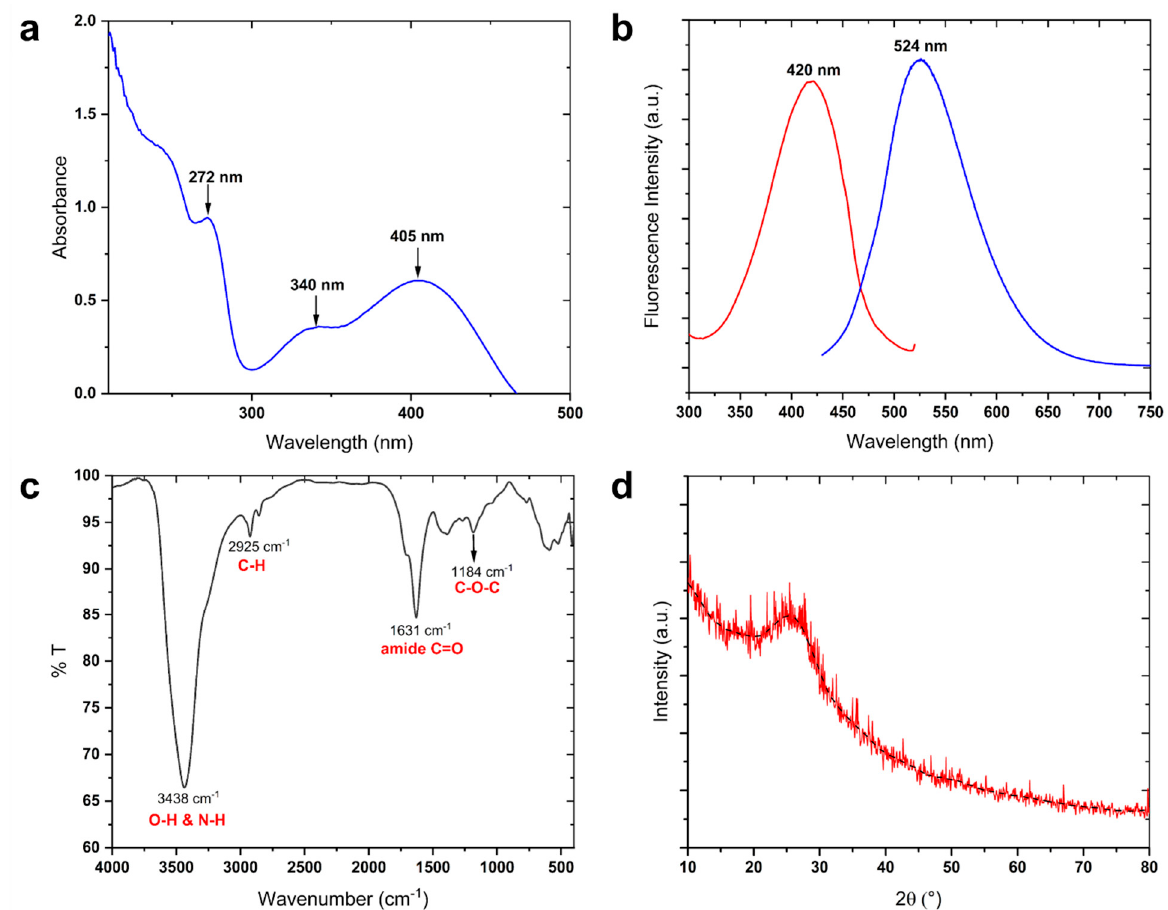
Figure 2. ( a ) UV-Vis spectrum of the microwave-synthesized C-dots showing three peaks at 405, 340, and 272 nm, ( b ) fluorescence spectrum of the microwave-synthesized C-dots showing excitation and emission peaks at 420 and 524 nm, respectively, ( c ) FTIR of the microwave-synthesized C-dots, and ( d ) XRD pattern of the microwave-synthesized C-dots.